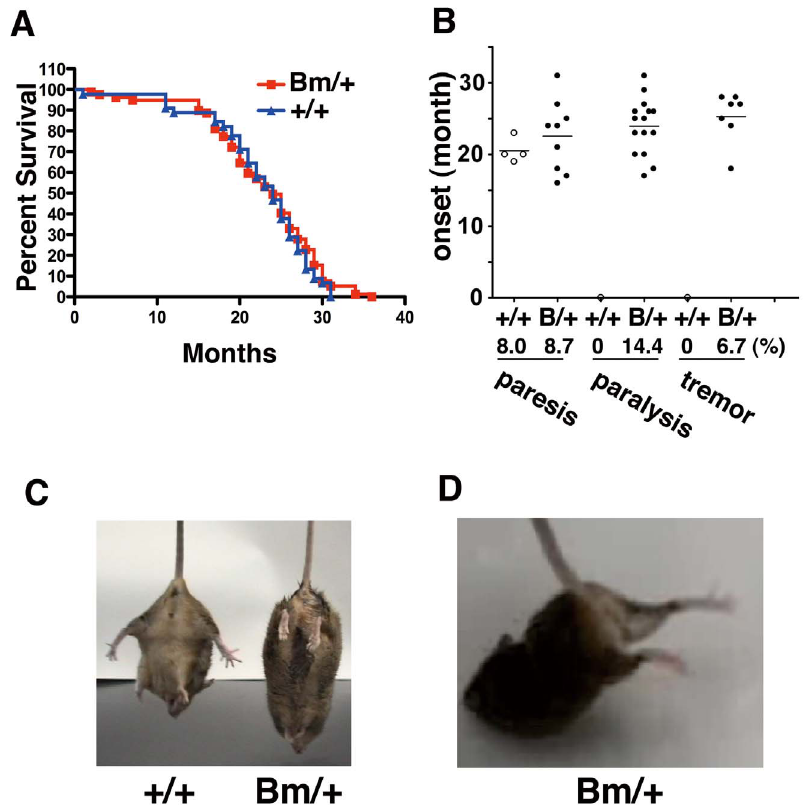
Figure 1. The mutant BiP mice revealed motor disabilities in aging. (A) Kaplan-Meier plots demonstrate that the heterozygous mutant BiP mice (Bm/ + , n=80) live as long as the wild-type mice ( + / + , n=45). (B) Some of the mutant BiP mice displayed paralysis and tremors after they were more than one year old. Heterozygous mutant BiP mice (Bm/ + , n=104) and wild type mice (n=50) more than 10 months old were observed. No sign of weakness; + / + 46/50, Bm/ + 73/104, tremor; + / + 0/50, Bm/ + 9/104, paresis of one hindlimb; + / + 4/50, Bm/ + 9/104, paralysis of one or both hindlimbs; + / + 0/50, Bm/ + 15/104. To compare values between two groups, Chi-square and Fisher’s exact test was done. Statistical significance was found. P value is 0.0033. (C) A seventeen month-old mutant BiP mouse displayed paralysis and loss of righting reflex. (D) A seventeen month-old mutant BiP mouse displayed paralysis (Video S1).